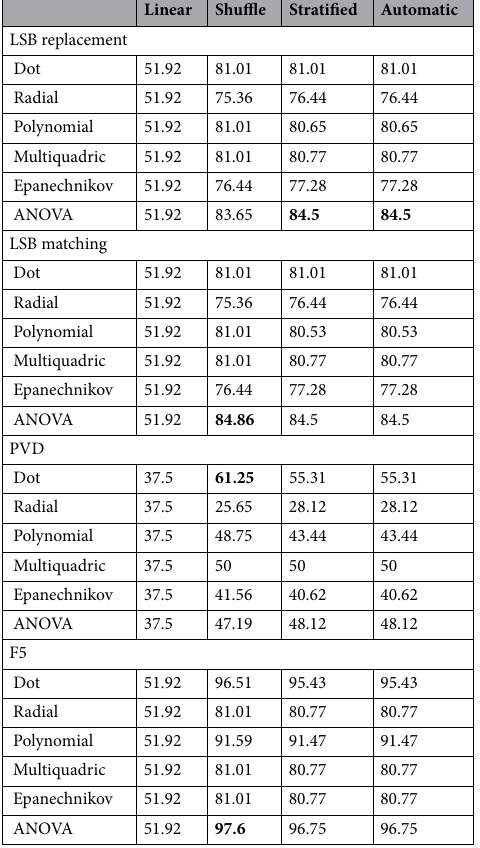
Linear Shuffle Stratified